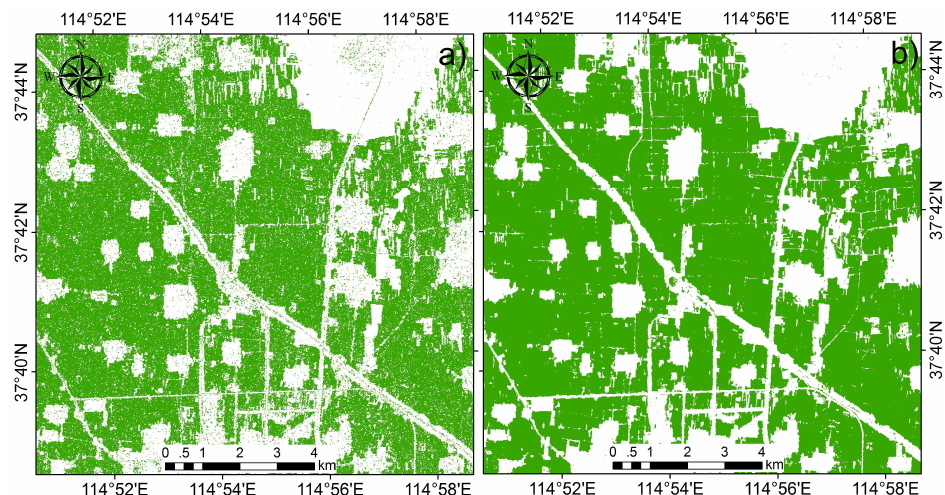
Figure 15. Comparison between the pixel-based classification result using only synthetic aperture radar (SAR) image metric composites ( a ) and optical and SAR image metric composites ( b ) as input. The corn map generated with only SAR image metric composites was subject to the speckle effect. Combined with optical images, this phenomenon can be constrained.